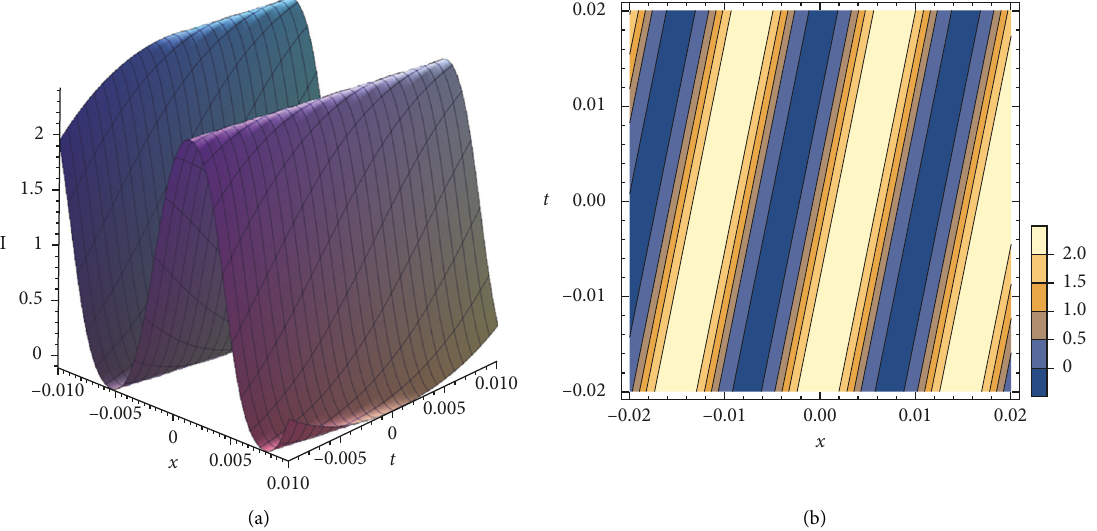
. 1 , h 0 . 002 , k 1 , l 0 0 . 002 , μ 0 . 0001 , ω 1 (cid:31) 0 (cid:31) (cid:31) (cid:31) (cid:31)